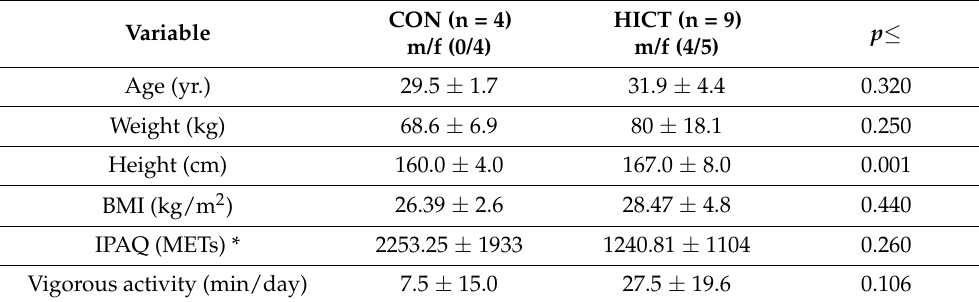
Table 1. Descriptive data of the sample.